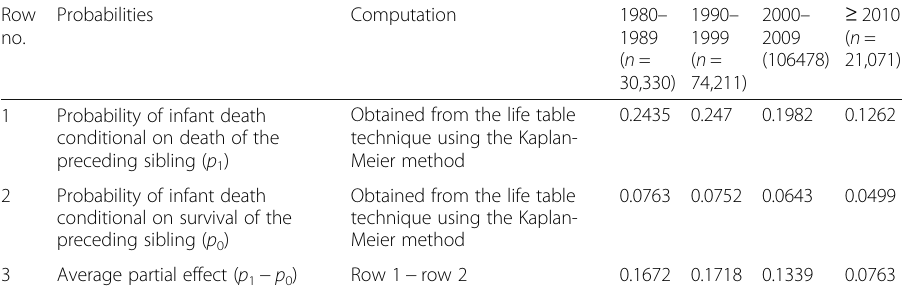
Table 3 Unadjusted average partial effect of sibling mortality correlation on probability of infant death in Nigeria, 1980 – 2013 Row no.